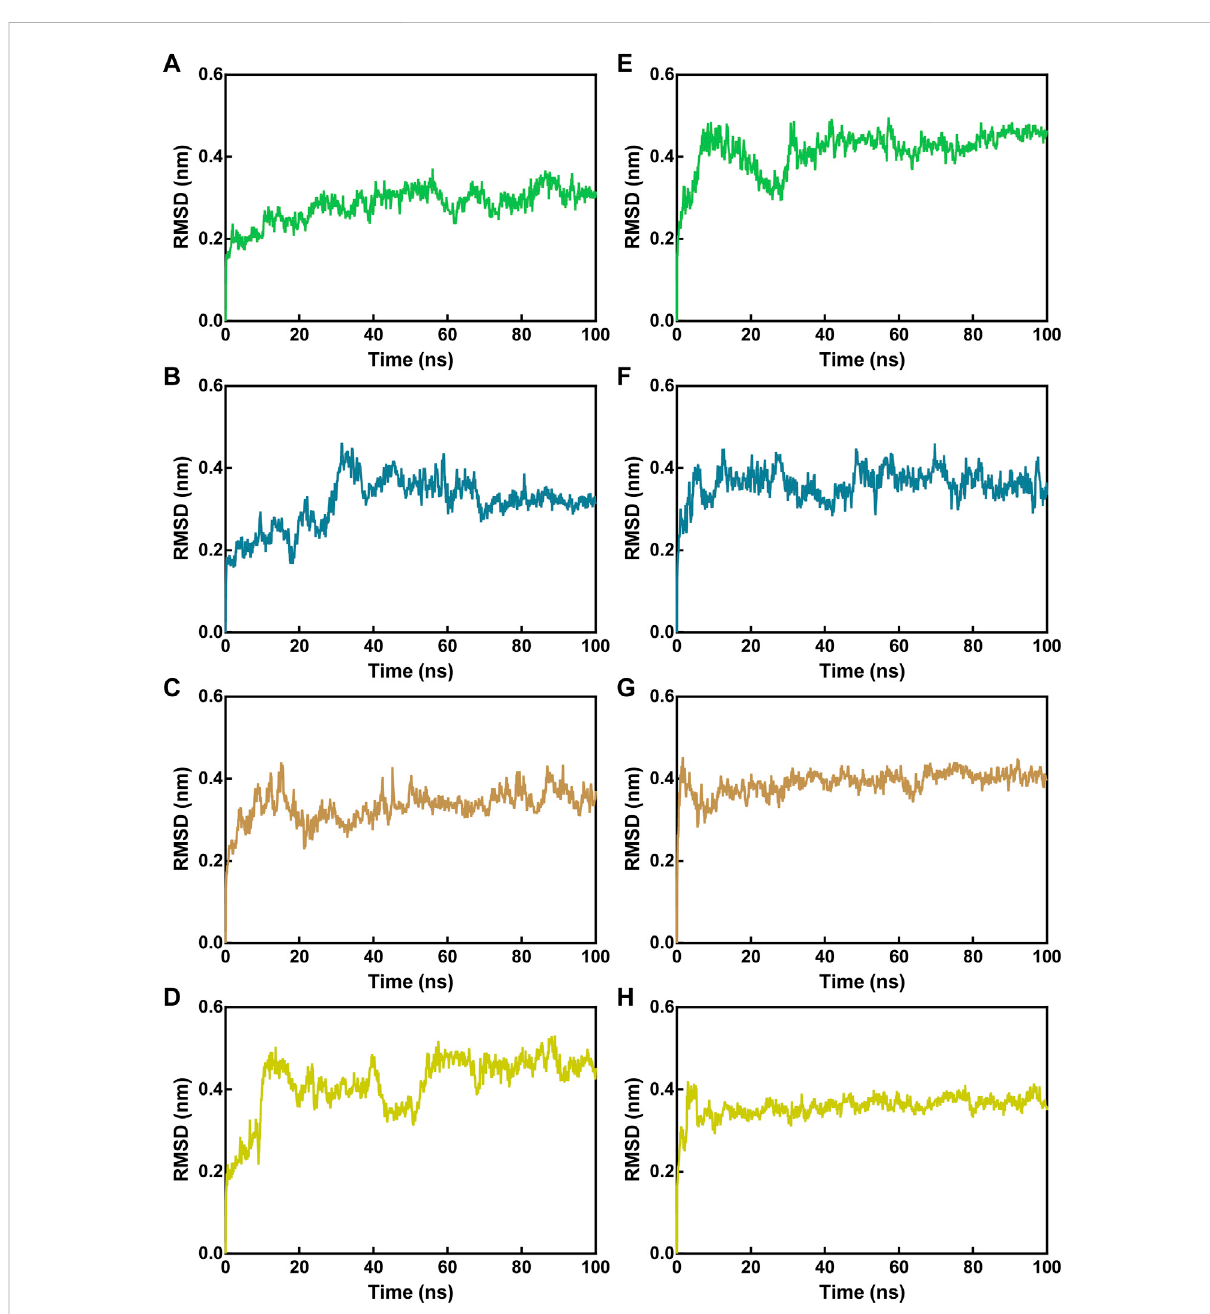
FIGURE 5 RMSD of C α atoms of Mpro-peptide and NRP1-peptide complex atoms with respect to the initial structures obtained from docking. (A – D) RMSD in Mpro-peptide complexes, and (E – H) RMSD in NRP1-peptide complexes. In all panels the color code is MN-1 (green), MN-2 (blue), MN-3 (brown), and MN-4